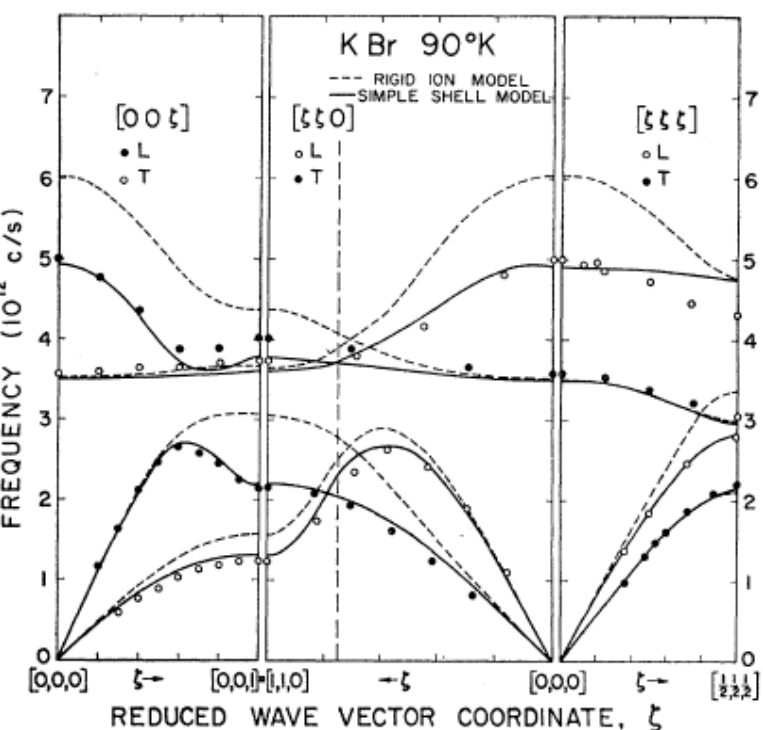
Figure 27. The phonon dispersion relations in potassium bromide measured at 90K, compared with calculated curves based on the rigid ion (dashed curve) and simple shell models (solid curves). This figure is taken from Figure 2 of ref. [72]. Copyright by the American Physical Society.